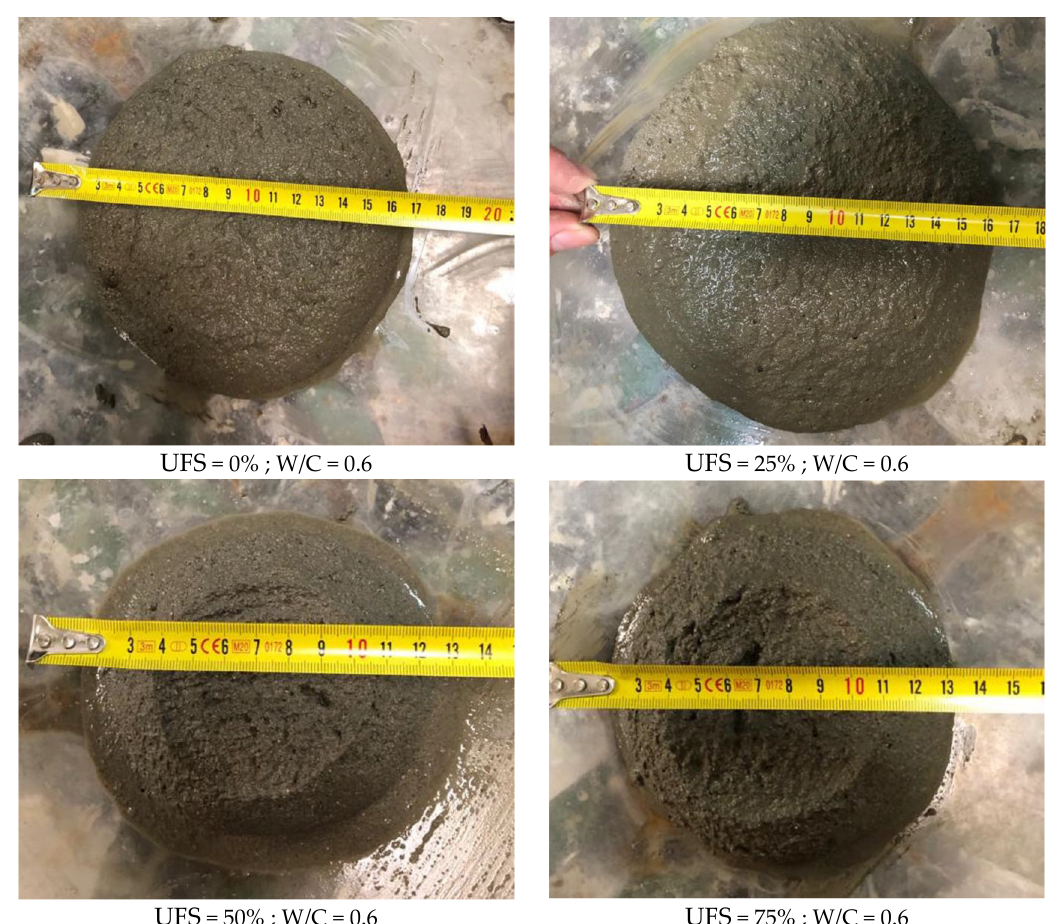
Figure 8. Mortar workability: slump table test results. Comparative example for a fixed W/C ratio.